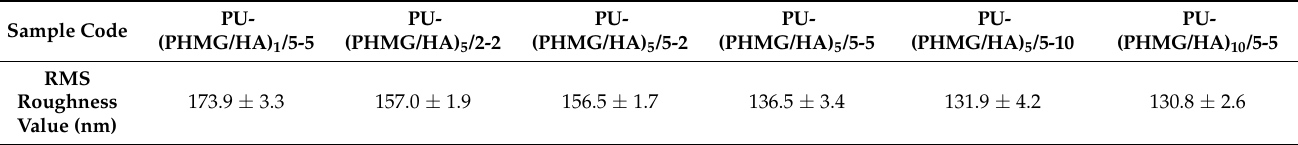
Figure 4. Atomic force microscopy (AFM) images of ( a ) PU; ( b ) PU-PHMG; ( c ) PU-(PHMG/HA) 5 /5-5. Table 2. The surface roughness value of the PU-(PHMG/HA) n